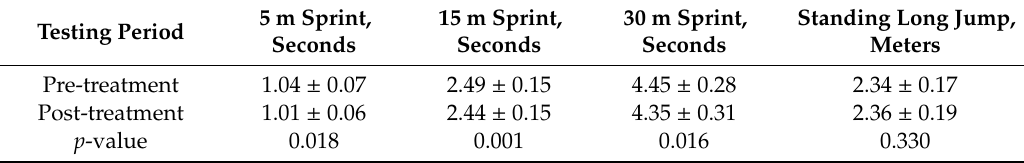
Table 3. Results of 5, 15, and 30 m sprint tests and the standing long jump test in group 1 pre- and post-treatment (mean value ± SD).